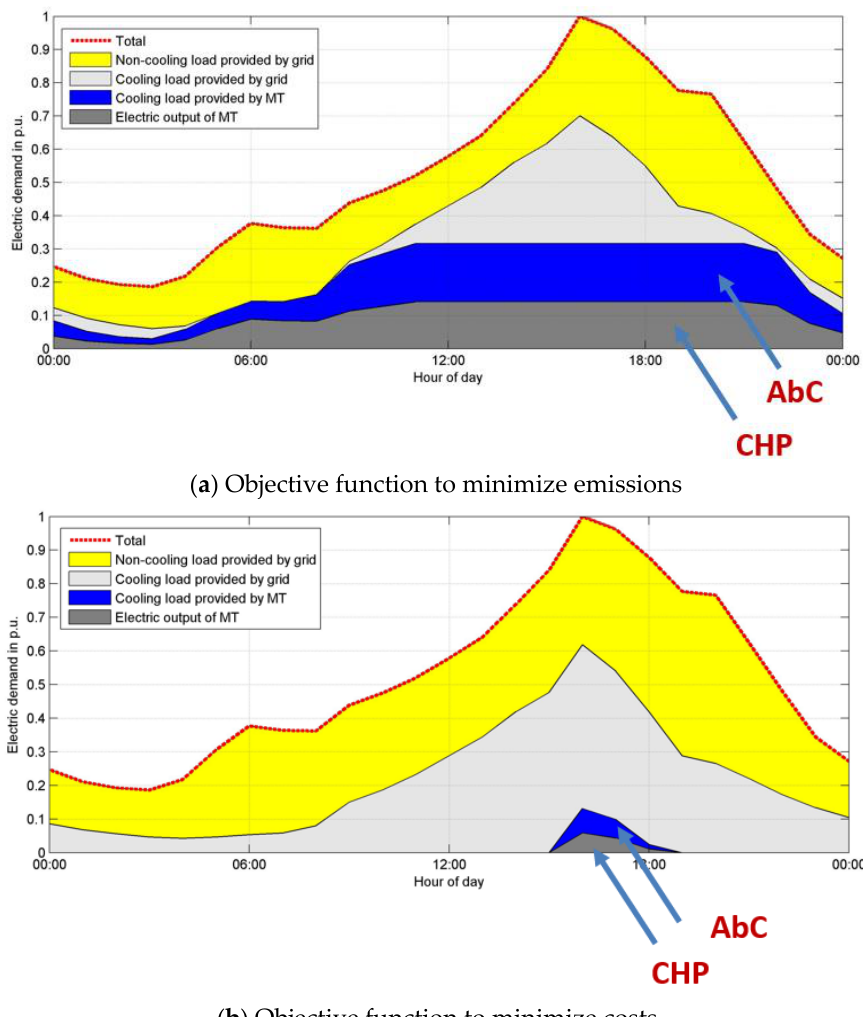
Figure 14. Daily generation profile for a peak day in the Atlanta area.